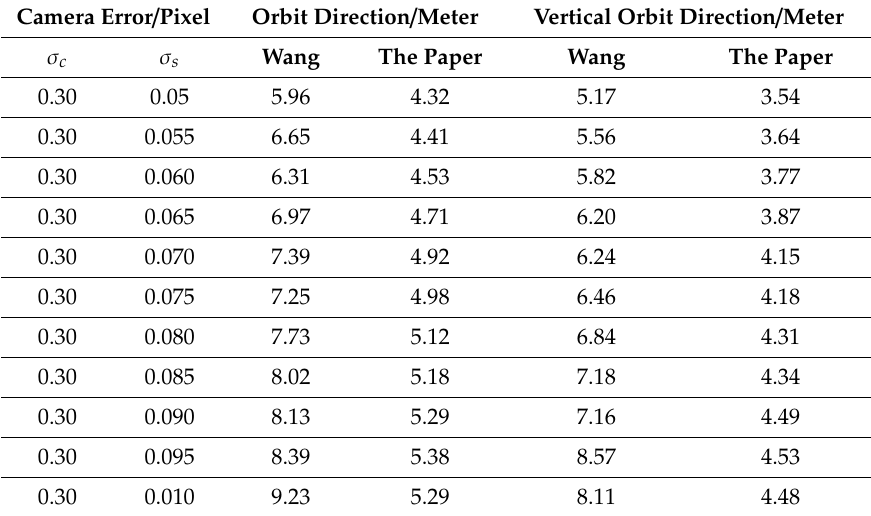
Table 5. Geo-Positioning Results of the Different Algorithm.